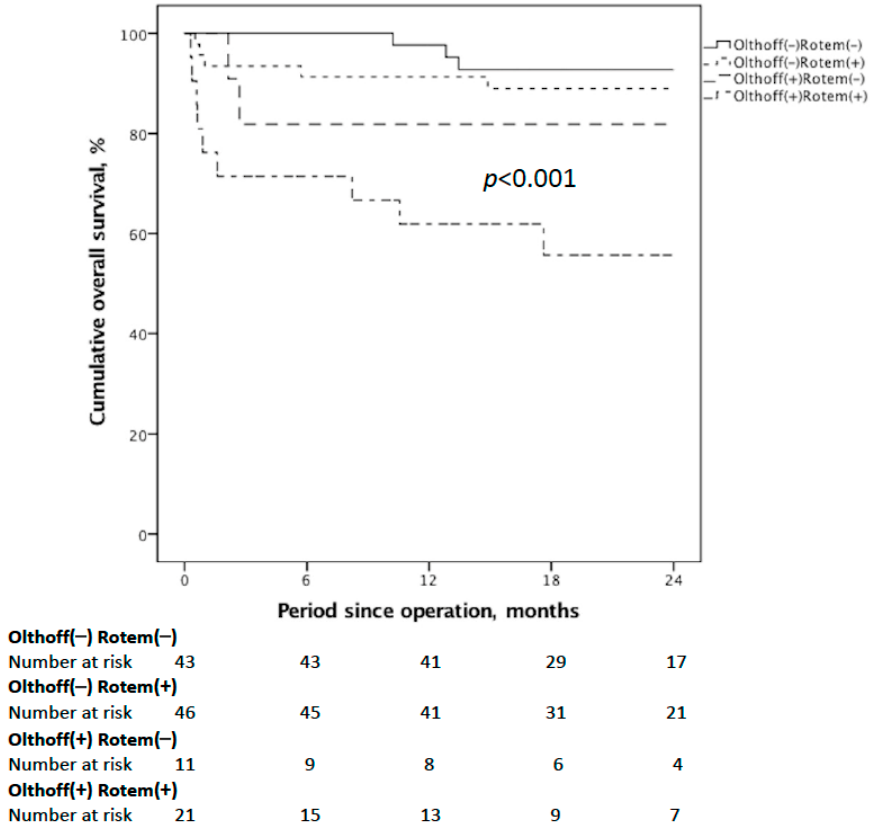
Figure 3. Cumulative OS curves for those meeting the Olthoff’s definition or 24 h post-LDLT ROTEM or not. ROTEM (+) is defined as at least one of the two above-mentioned 24 h post-LDLT ROTEM parameters being prolonged beyond the optimal cut-off values as mentioned. The Olthoff (+) ROTEM (+) group had the worst OS ( p < 0.001).